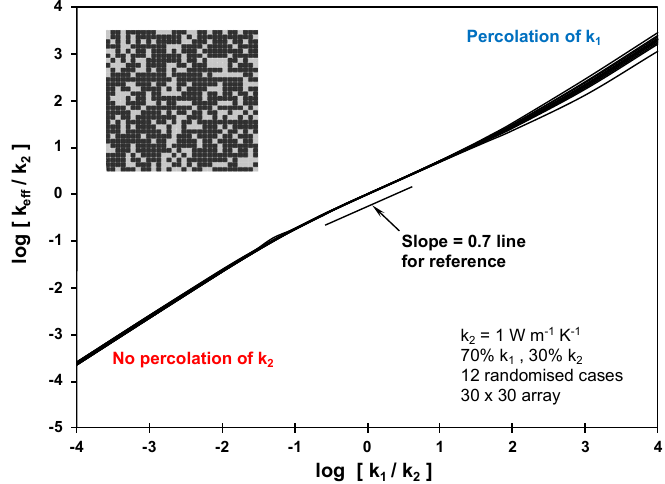
Figure 4. Log-log plot of the equivalent conductivity as a function of k 1 / k 2 for the 70% k 1 –30% k 2 system ( α 1 = 0.7). Phase k 1 (black) is variable and k 2 (grey) is constant.